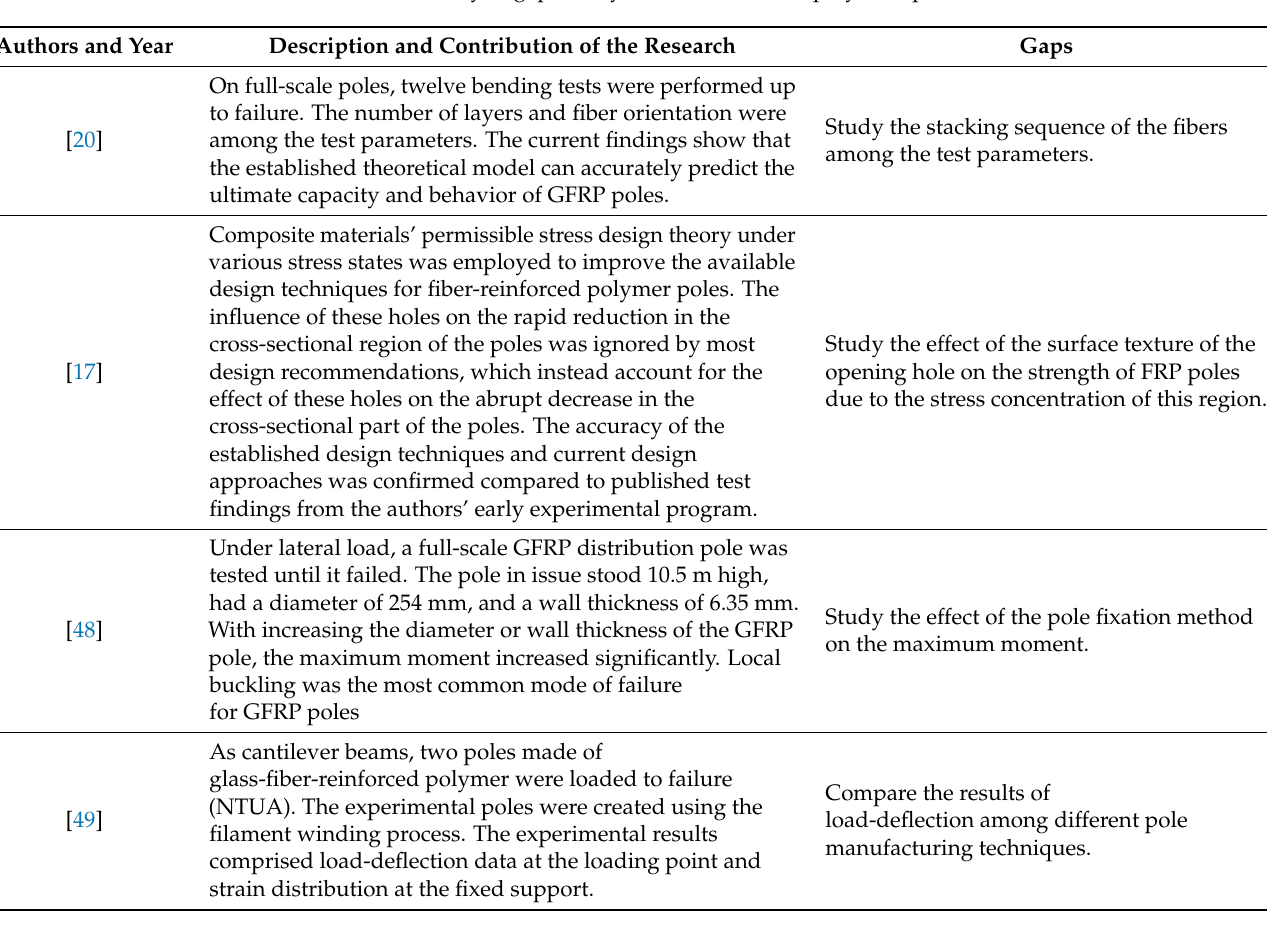
Table 9. Summary of gaps study of fiber-reinforced polymers